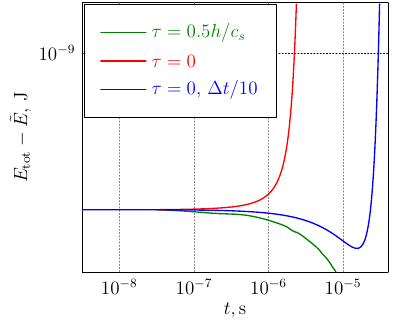
Figure 8. Problem 3.2: distribution of C for t = 3 . 5 10 6 ∆t obtained by scheme A ·